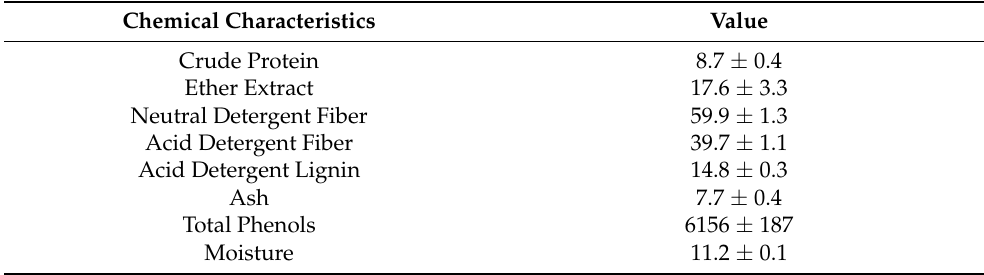
Table 3. Dried destoned virgin olive pomace (DDVOP) chemical characteristics. The data repre- sent the mean values of three replications with their relative standard deviation (RSD). Values are expressed as the percentage of dry matter (g/100 g DM). Phenols are expressed as mg/kg.